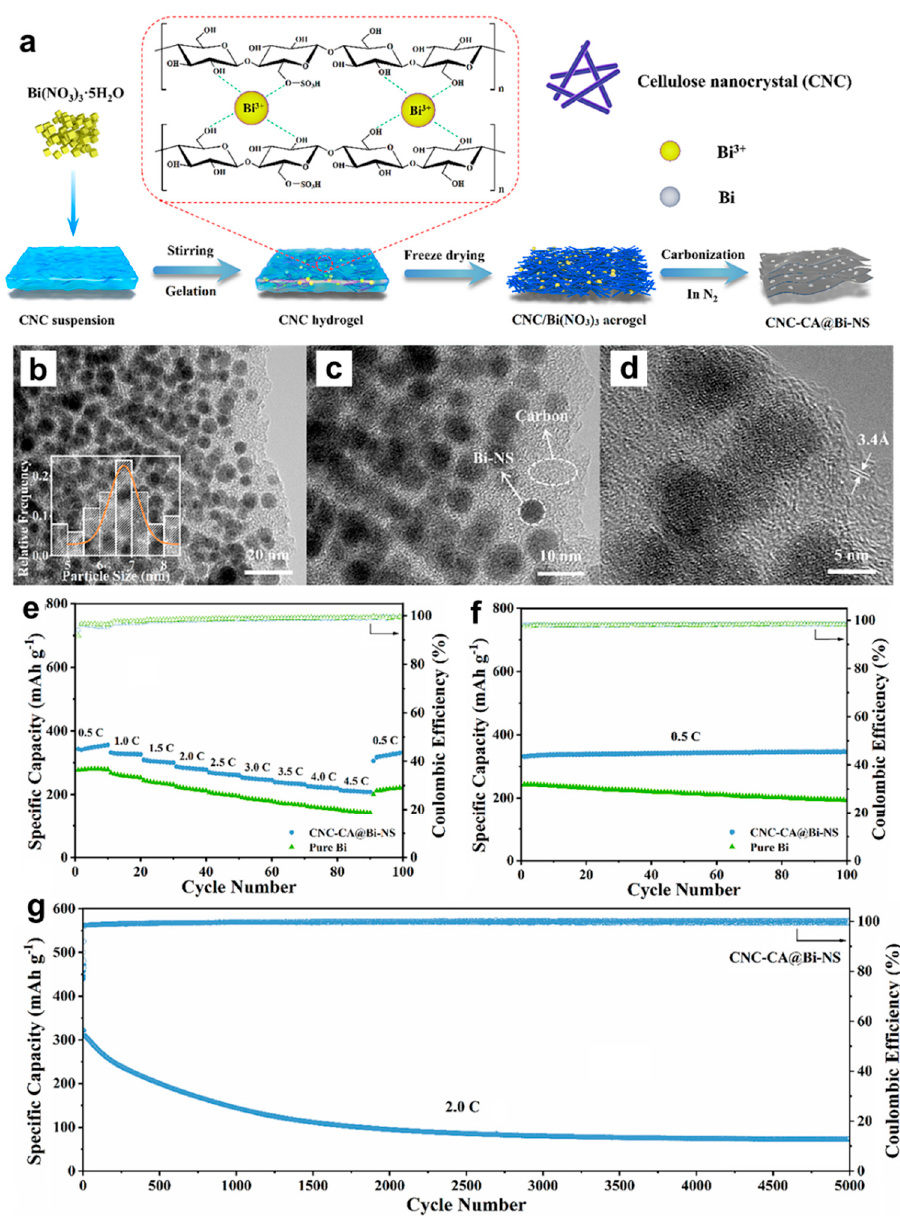
Figure 7. ( a ) Schematic illustration of the fabrication process of CNC-CA@Bi-NS. ( b – d ) HRTEM images of CNC-CA@Bi-NS at different magnifications. ( e ) Rate performance and ( f ) cycling stability of pure Bi powder and CNC-CA@Bi-NS electrodes. ( g ) Long-term cycling stability of the CNC-CA@Bi-NS electrode at 2.0 C for 5000 cycles. Reproduced with permission [34]. Copyright 2023, Elsevier B.V.